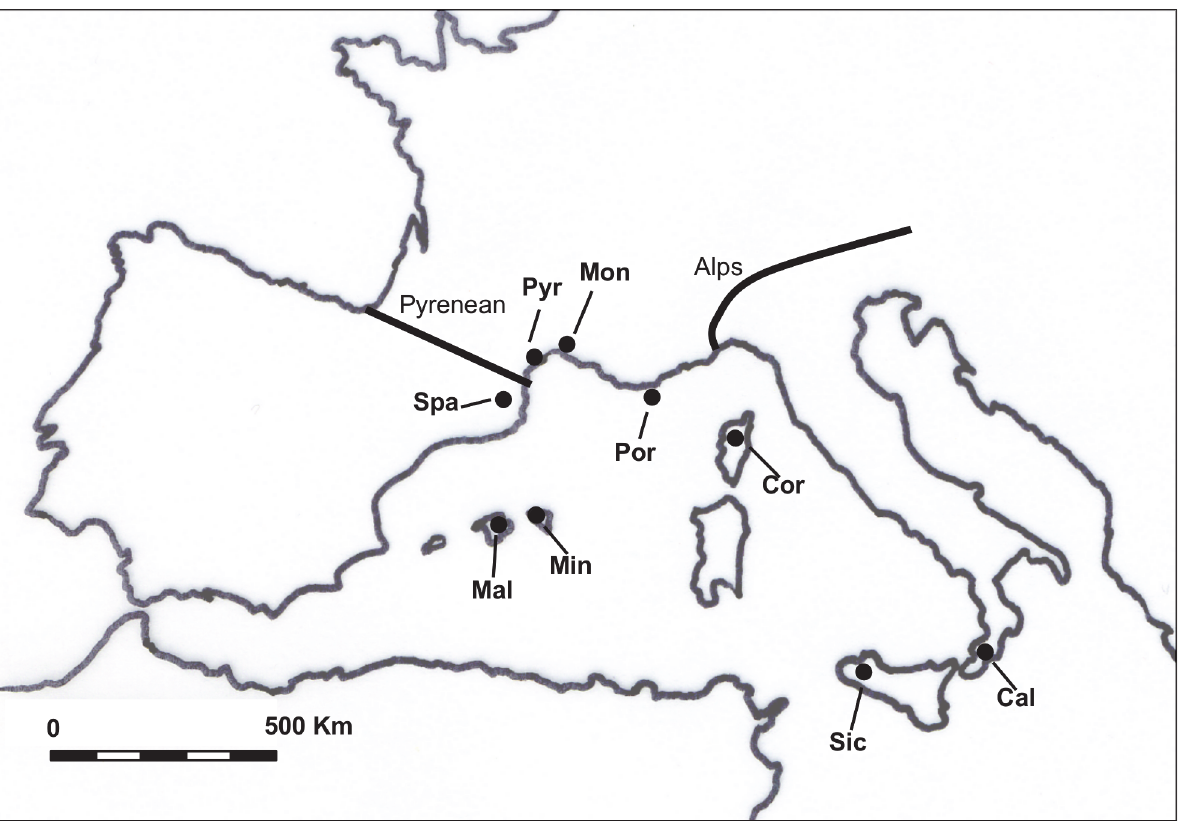
Fig 1. Trapping locations of Apodemus sylvaticus . Samples are designated according to the location in which they were collected. The number of examined field mice is indicated between brackets. Spa, Montseny (42); Pyr, the Pyrenees (15); Mon, Montpellier (21); Cal, Calabria (39); Mal, Mallorca (25); Min, Minorca (14); Sic, Sicily (32); Por, Porquerolles (10); Cor, Corsica (5). The thick lines correspond to the main European biogeographic barriers: the Pyrenees (west) and the Alps (east). Sample locations are shown by